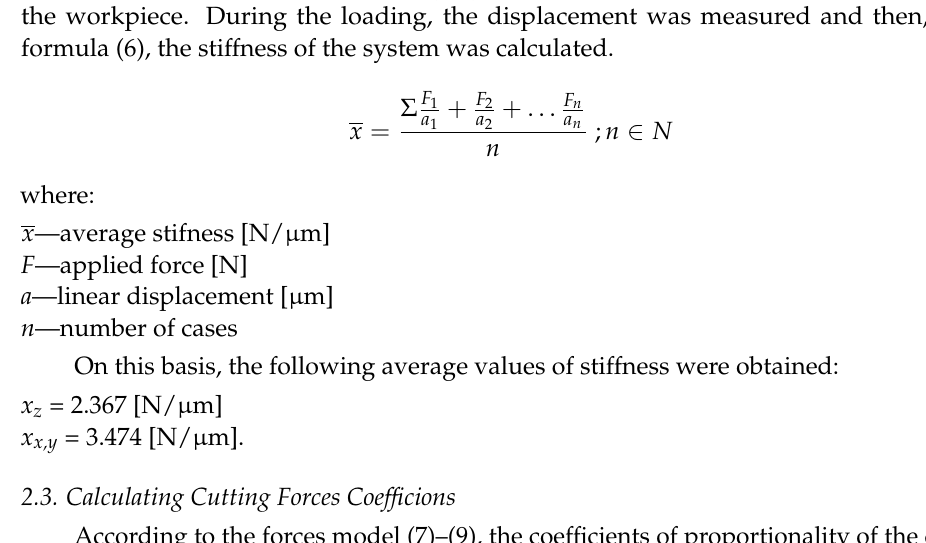
Figure 5. Scheme of the milling cutter measuring station in the x and y axes.